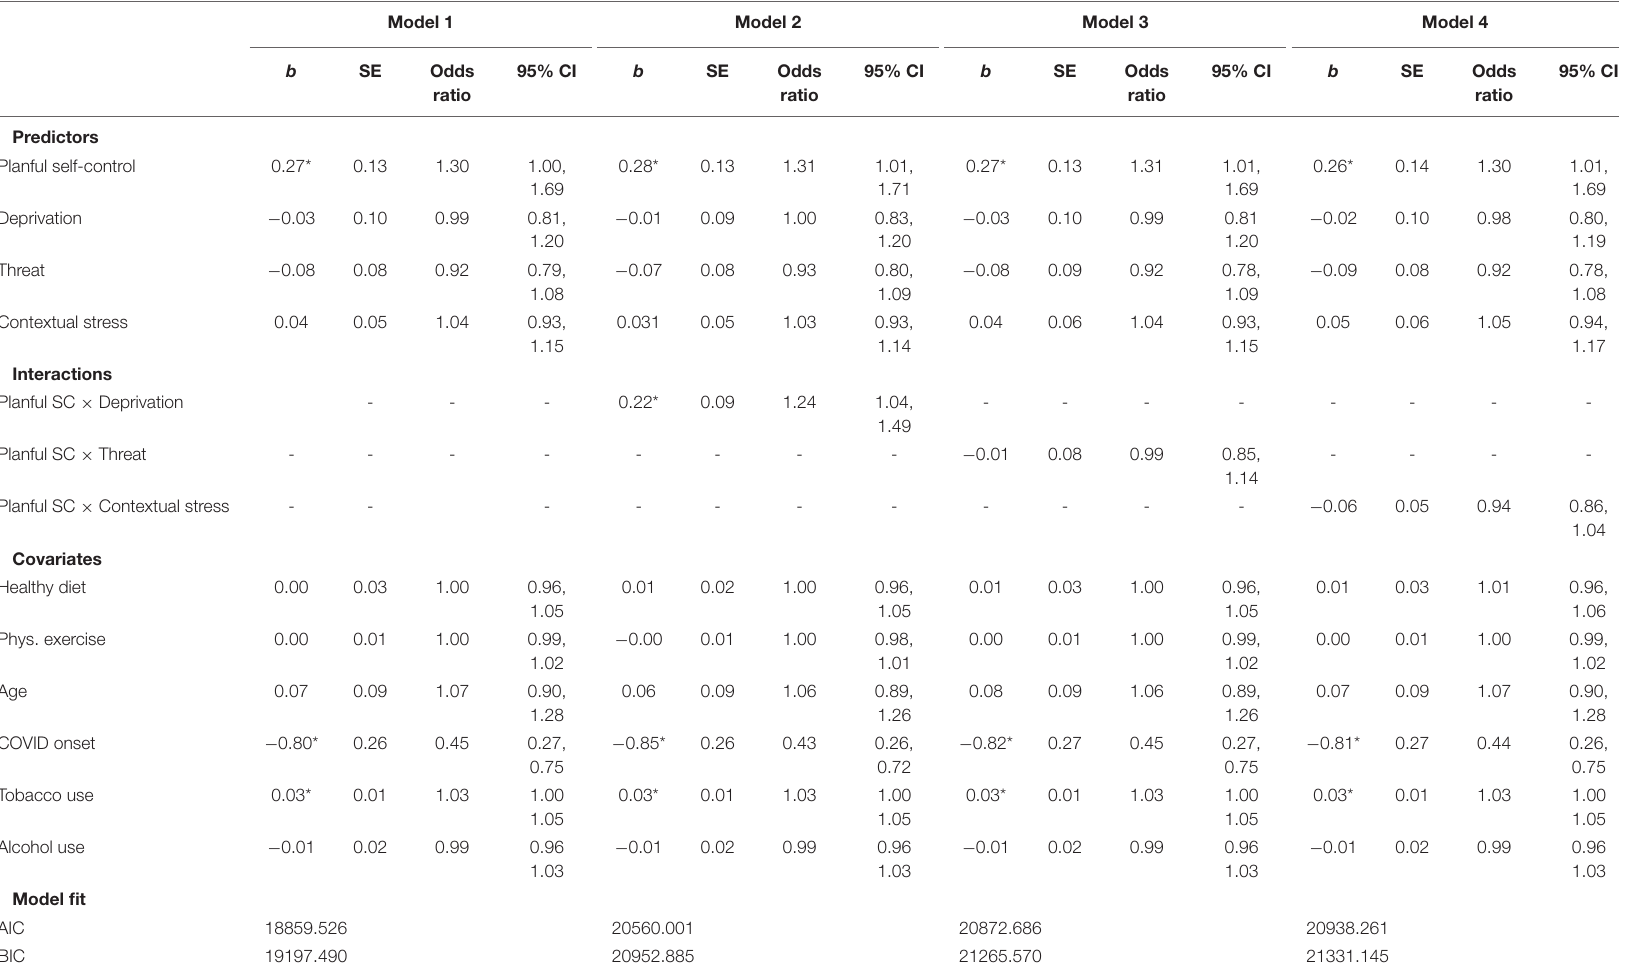
TABLE 3 | Effects of childhood threat, deprivation, and contextual stress by striving on metabolic